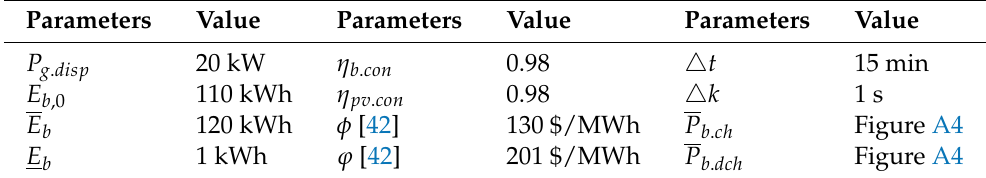
Table 2. System parameters.